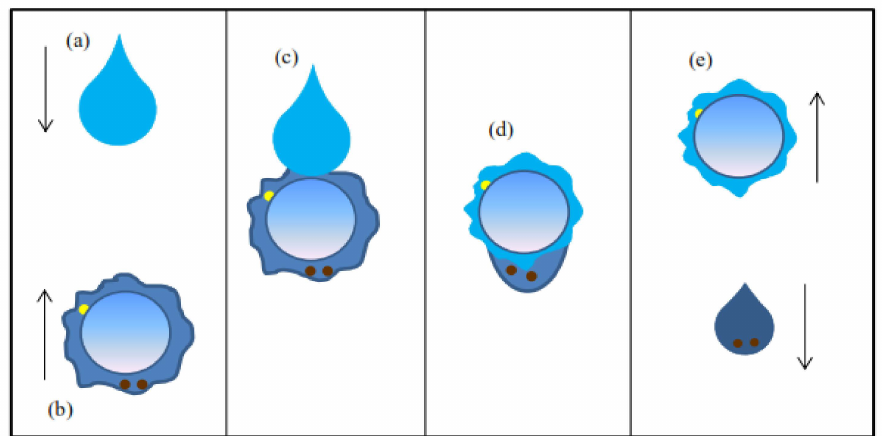
Figure 1. The ideal mechanism of froth washing ( a ) drop of water descending into the froth, ( b ) mineral-laden air bubble ascending in the froth with associated entrained water and particles ( c ) contact between the wash water and the air bubble, ( d ) the descending droplet of water displaces the entrained water and particles and, ( e ) entrained particles flow back into the pulp while the bubble with clean water rises